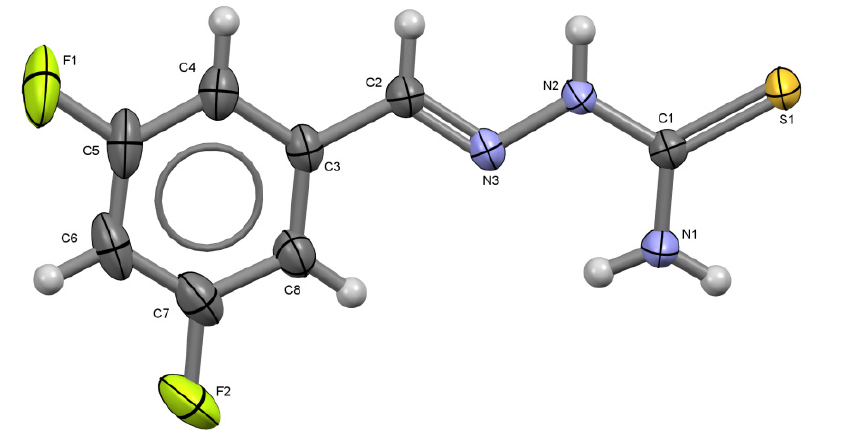
H F-C(C H )=N-NH-C(S)NH ( 6 ). Thermal ellipsoids 6 4 6 5 2